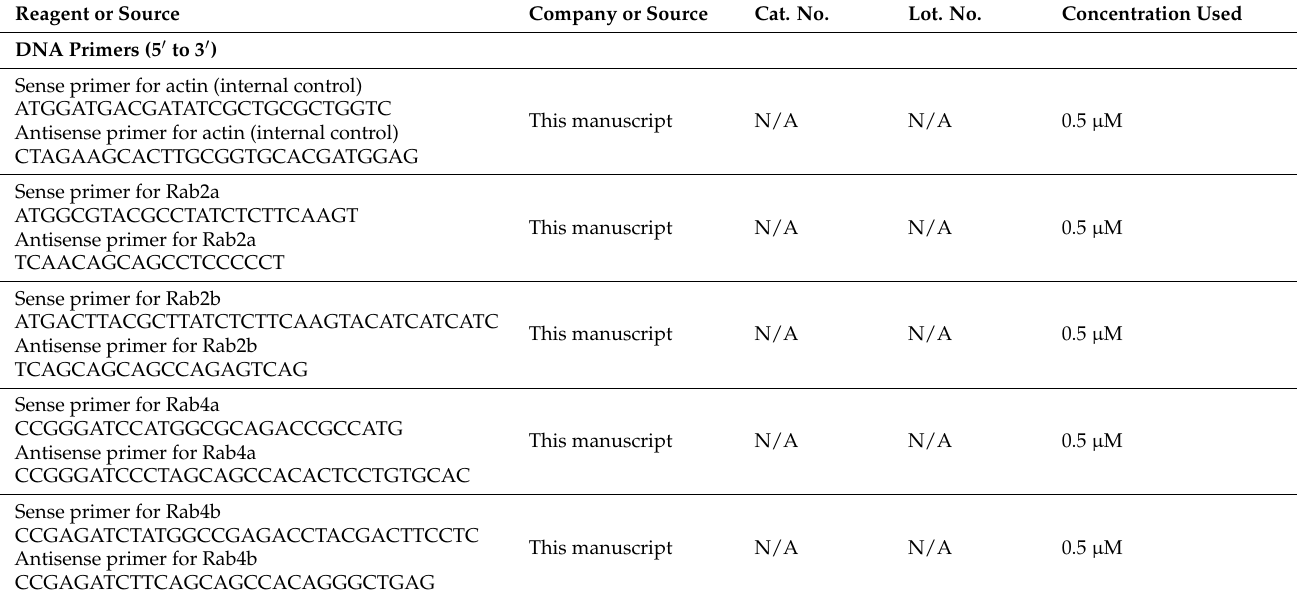
Table 5. List of DNA